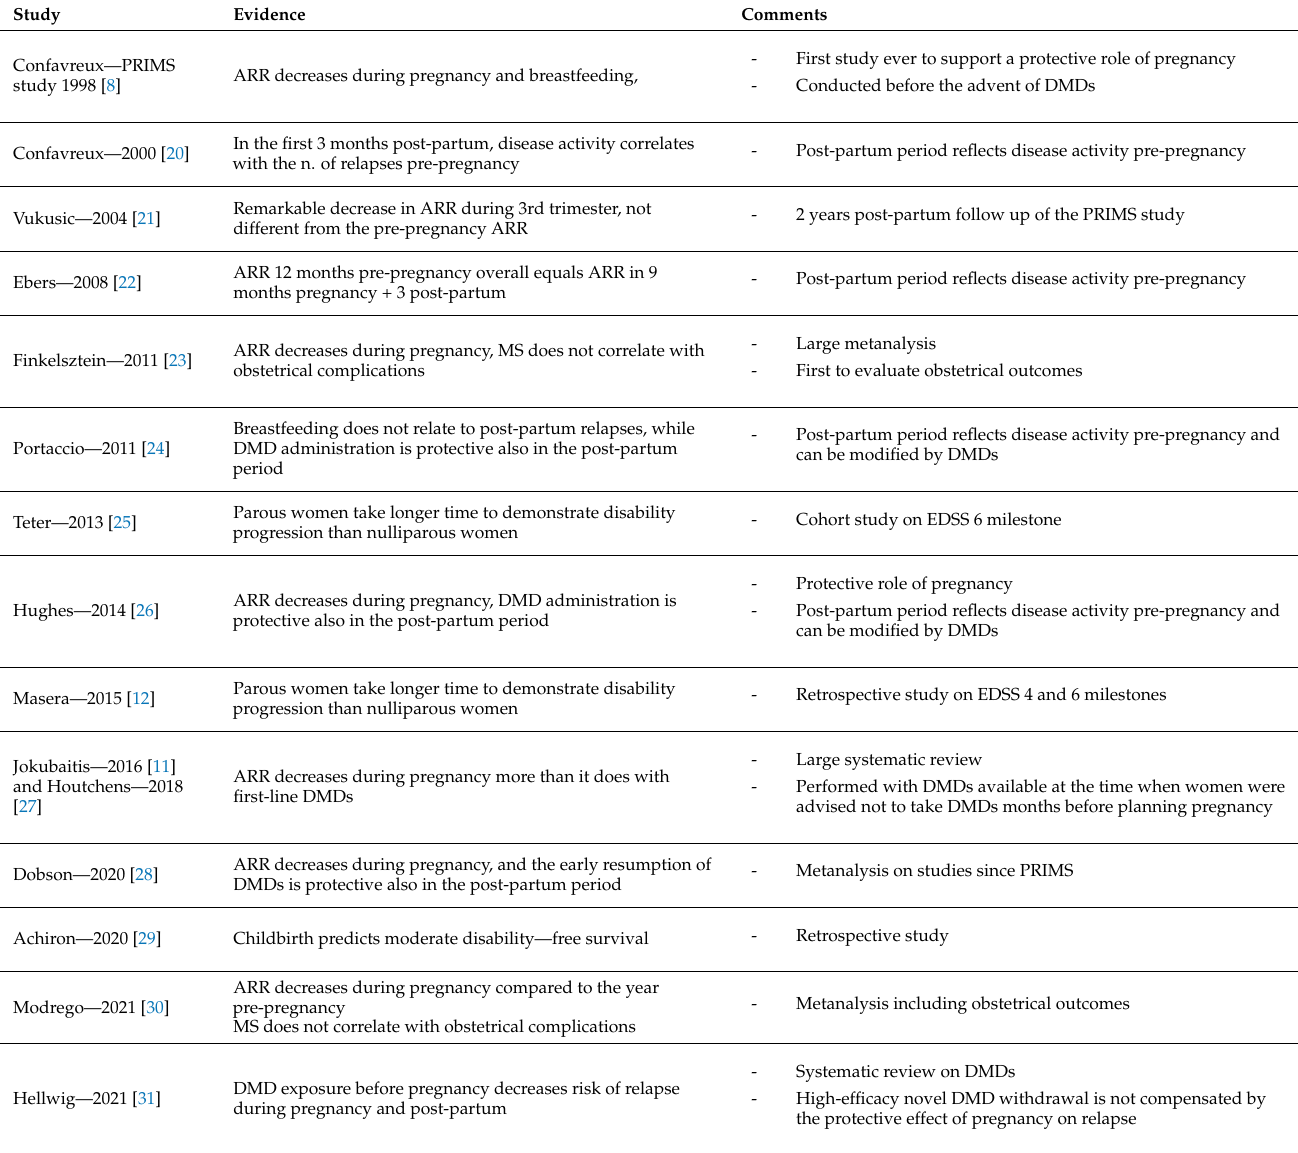
Table 1. Summarizing table of studies on the impact of pregnancy and breastfeeding in MS, comments and evidence